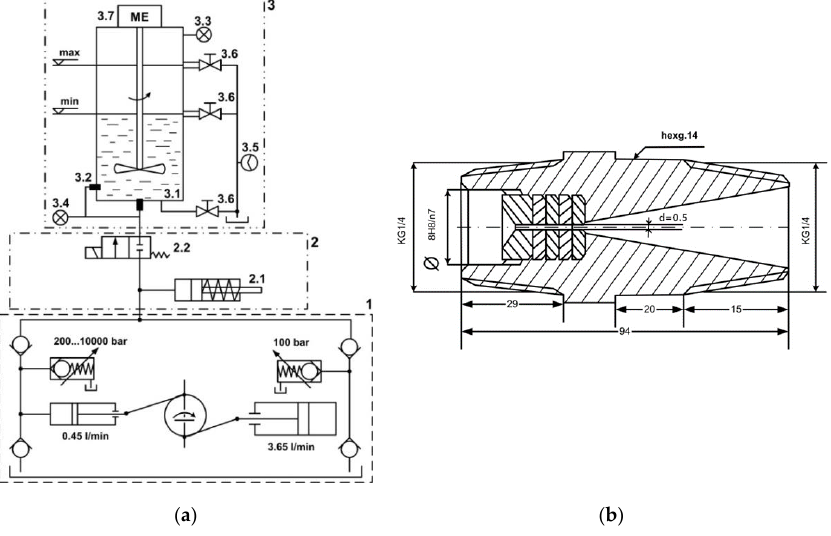
Figure 1. ( a ) Cavitation jet system (1—Plunger pump system; 2—Pressure distribution system: 2.1—Accumulator, 2.2—Electric distributer; 3—Test chamber: 3.1 and 3.2—Nozzle, 3.3—Low pressure transducer, 3.4—High pressure transducer, 3.5—Flow indicator, 3.6—Valve, 3.7—D.C. motor and propeller) and ( b ) Cavitation nozzle.